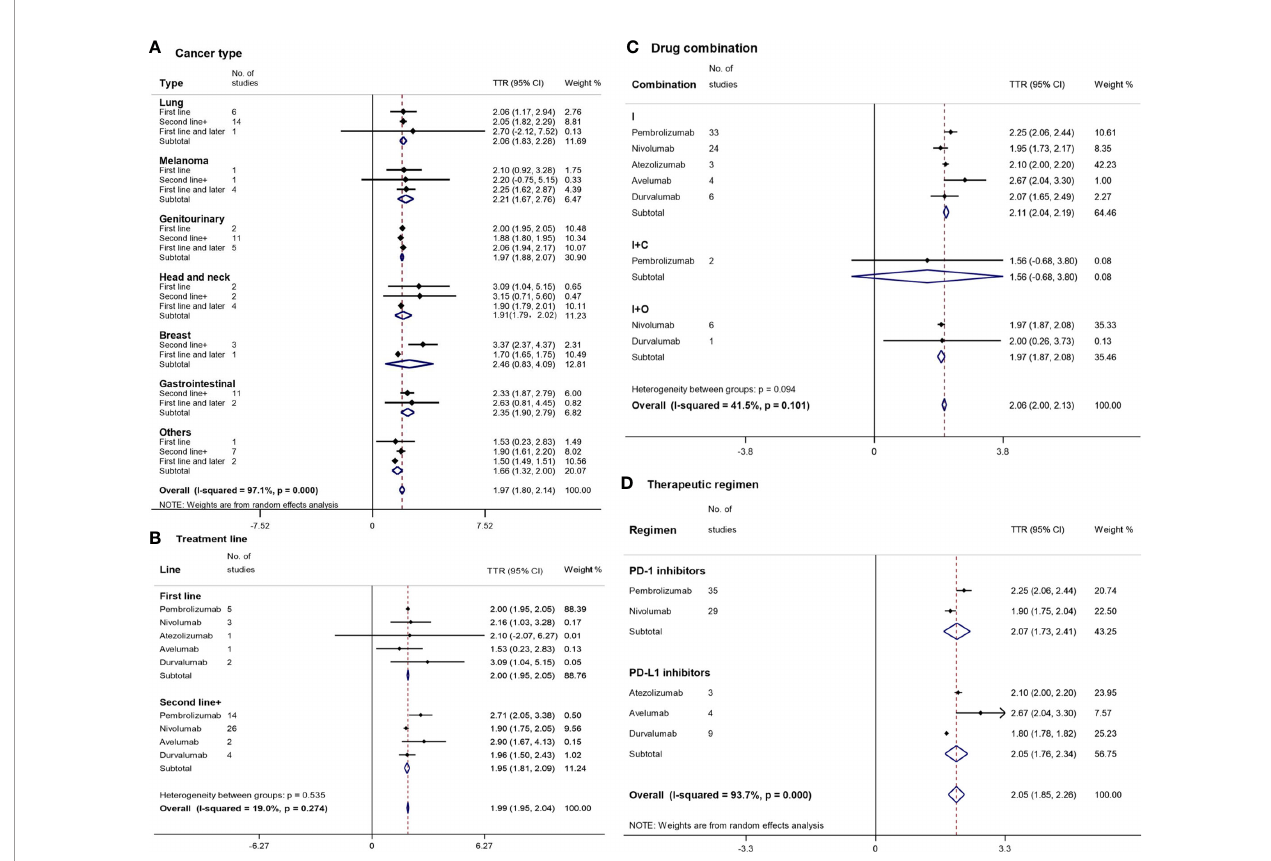
FIGURE 3 | Forest plot for time to response (TTR) by cancer type (A) , treatment line (B) , drug combination (C) , and therapeutic regimen (D) . Squares represent the study-speci fi c effect size (TTR). The area of a square is inversely proportional to the standard error of the study (and therefore indirectly to the sample size), and a larger area indicates greater weight in the calculation of the pooled effect size. The horizontal line crossing the square represents the 95% CI. The diamonds represent the estimated overall effect based on the meta-analysis. CI, con fi dence